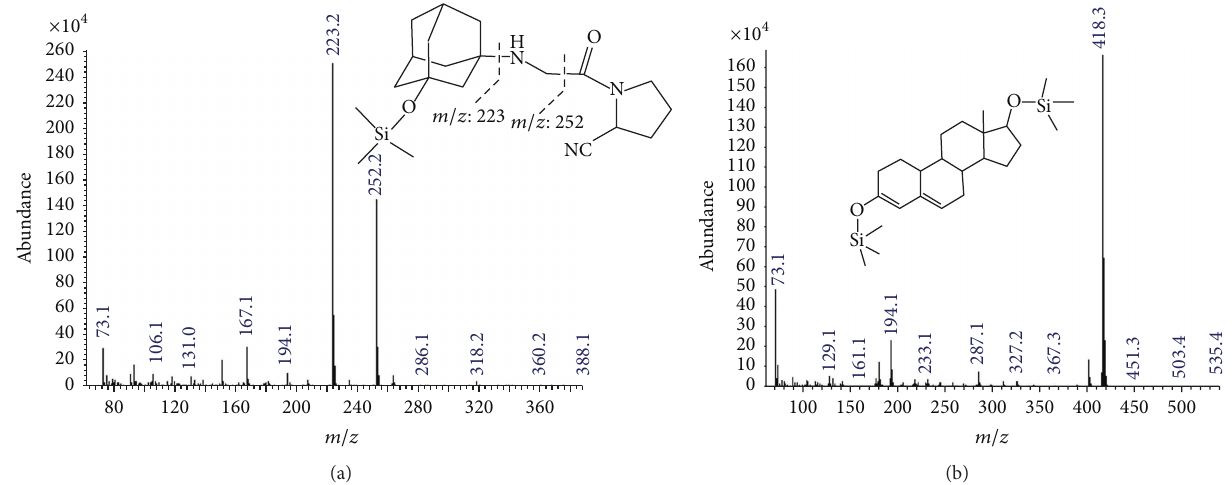
Figure 1: Mass spectrum of the O-TMS derivative of VIL (a) and bis-OTMS derivative of IS (b).